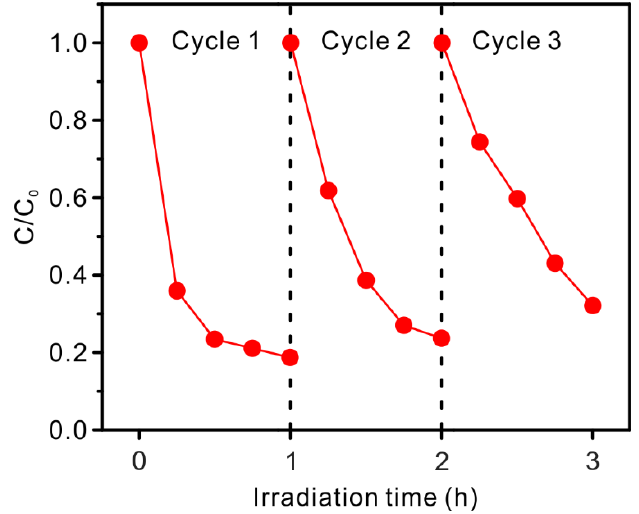
Figure 7. Recycling properties of the C 3 N 4 Zn 0.61 O 0.61 photocatalyst.